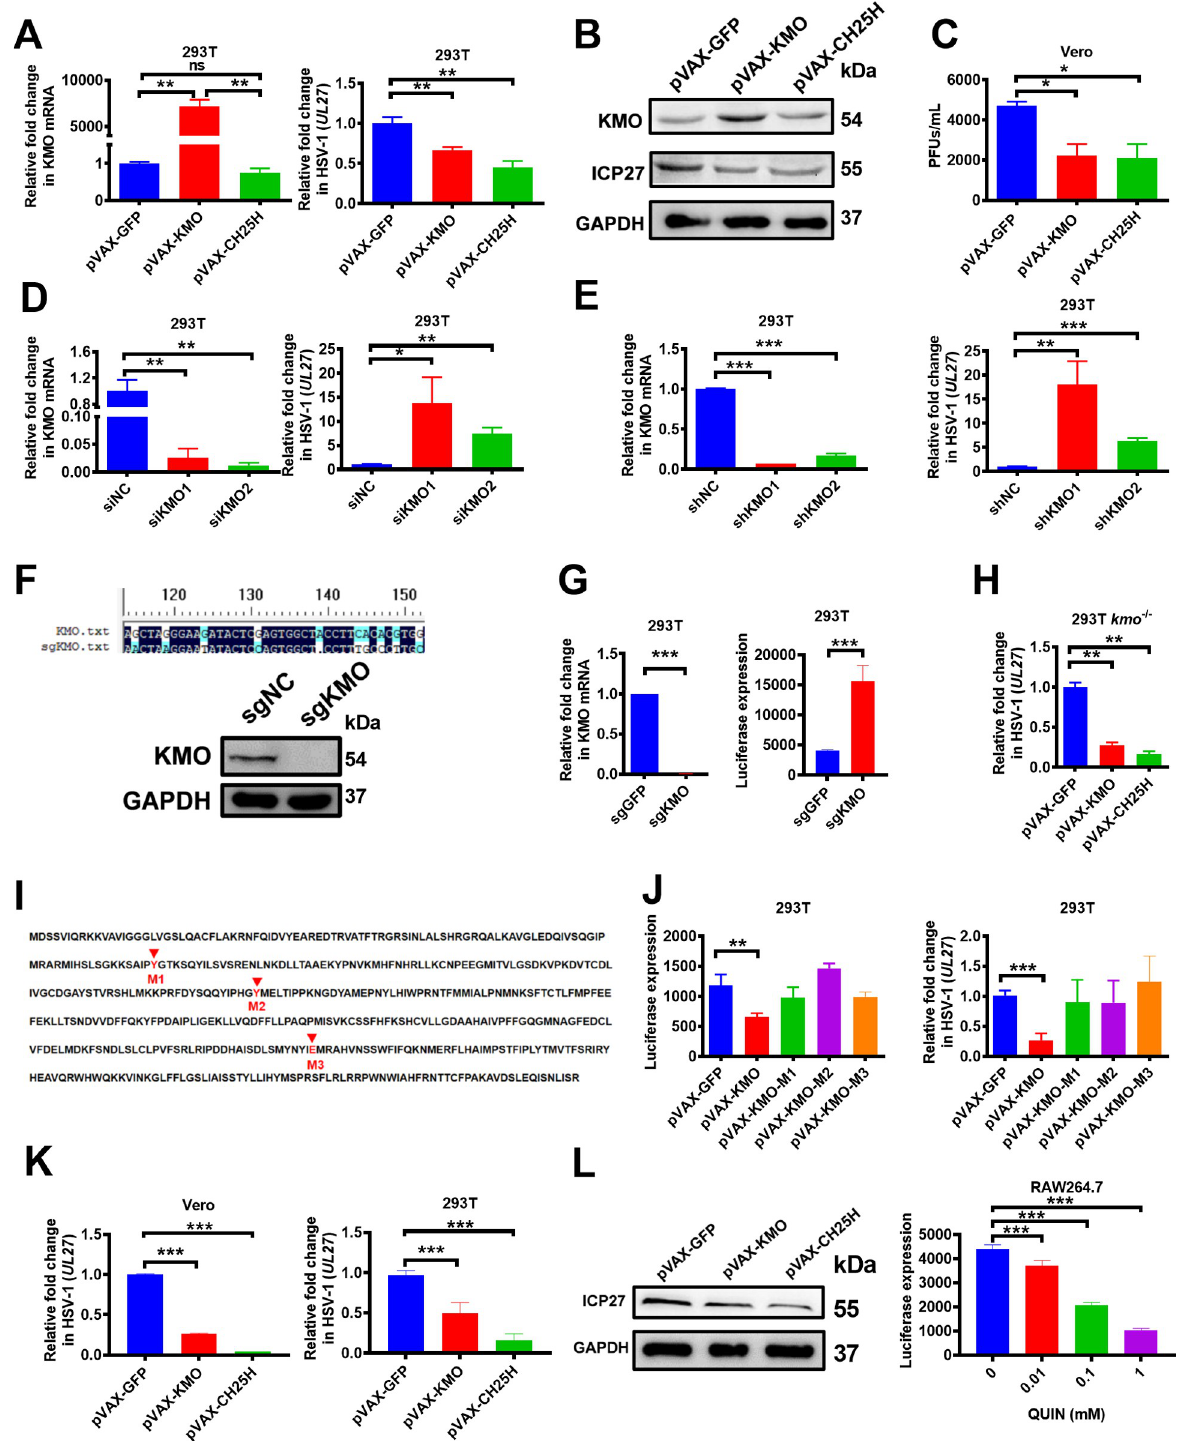
Fig 2. The antiviral activity of KMO through its enzymatic product QUIN. (A) 293T cells were transfected with plasmids (1 μ g/mL) expressing GFP, KMO, CH25H for 24 h respectively, followed by HSV-1 infection for 8 h at MOI of 0.25. Then the expression of KMO and HSV-1 UL27 were measured by RT-qPCR. (B) 293T cells were transfected with plasmids (1 μ g/mL) expressing GFP, KMO, CH25H for 24 h respectively, followed by HSV-1 infection for 8 h at MOI of 0.25. Then the expression of KMO and HSV-1 ICP27 protein were measured by Western Blotting Analysis. (C) 293T cells were transfected with plasmids (1 μ g/mL) expressing GFP, KMO, and CH25H for 24 h, respectively, followed by HSV-1 infection for 8 h